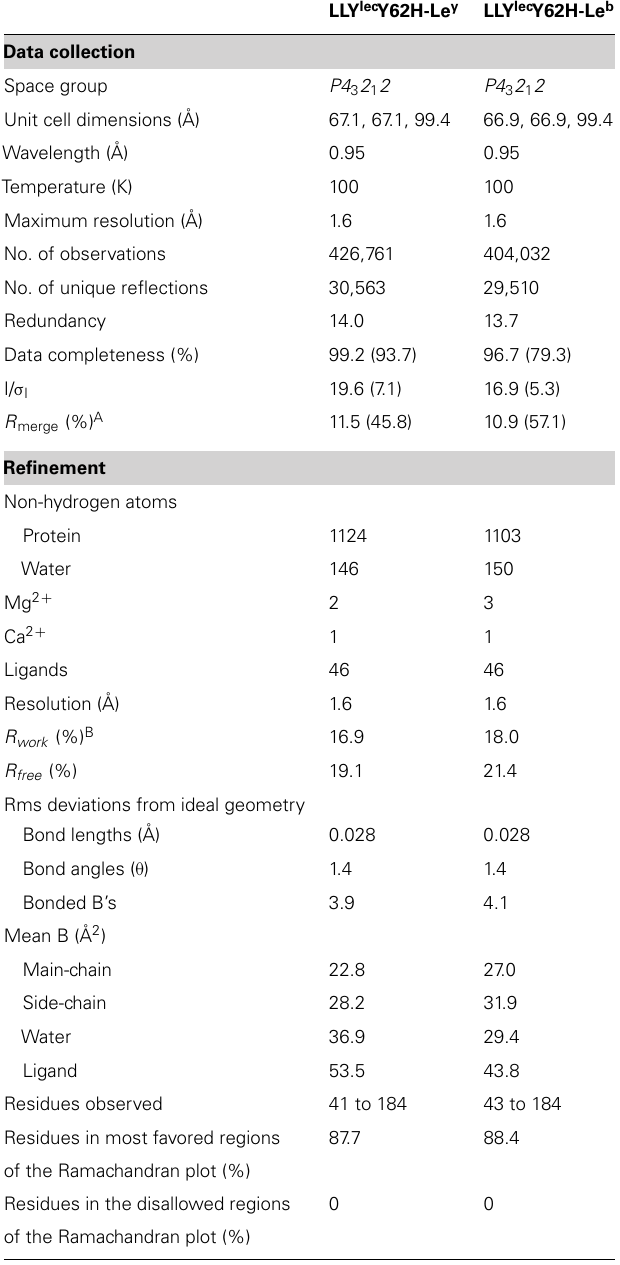
Table 1 | Estimated equilibrium dissociation constants ( K D ) for LLY lec Y62H and LLY lec wt domains interacting with Le y and Le b antigens.